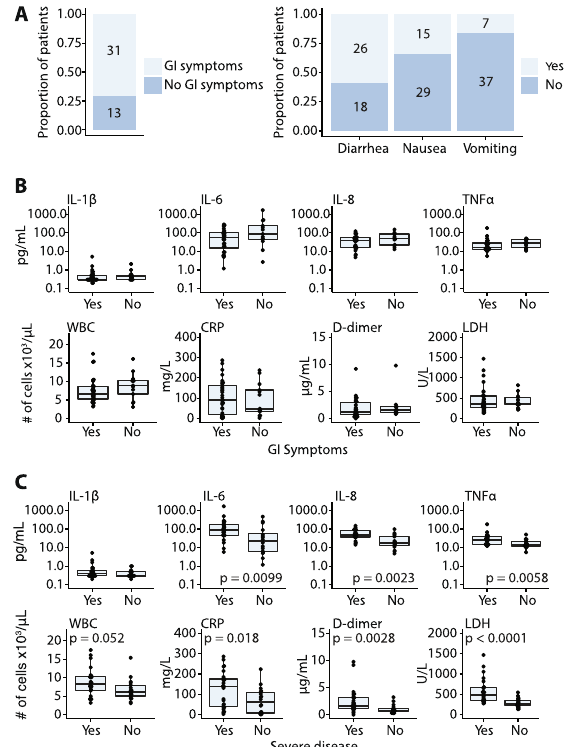
Figure 1. Gastrointestinal (GI) symptoms and serologic parameters in hospitalized COVID-19 patients. ( A ) Proportion of patients with GI manifestations in this cohort of hospitalized COVID-19 patients in whom stool samples obtained. ( B ) Serum concentrations of IL-1β, IL-6, IL-8, and TNFα and select laboratory values at the time of admission in patients with and without GI symptoms and ( C ) in patients with severe compared with non-severe COVID-19 disease . Each point represents an individual value for a patient, the box plot represents the median and the interquartile range and the p values calculated using the Mann–Whitney test with significance defined as p <